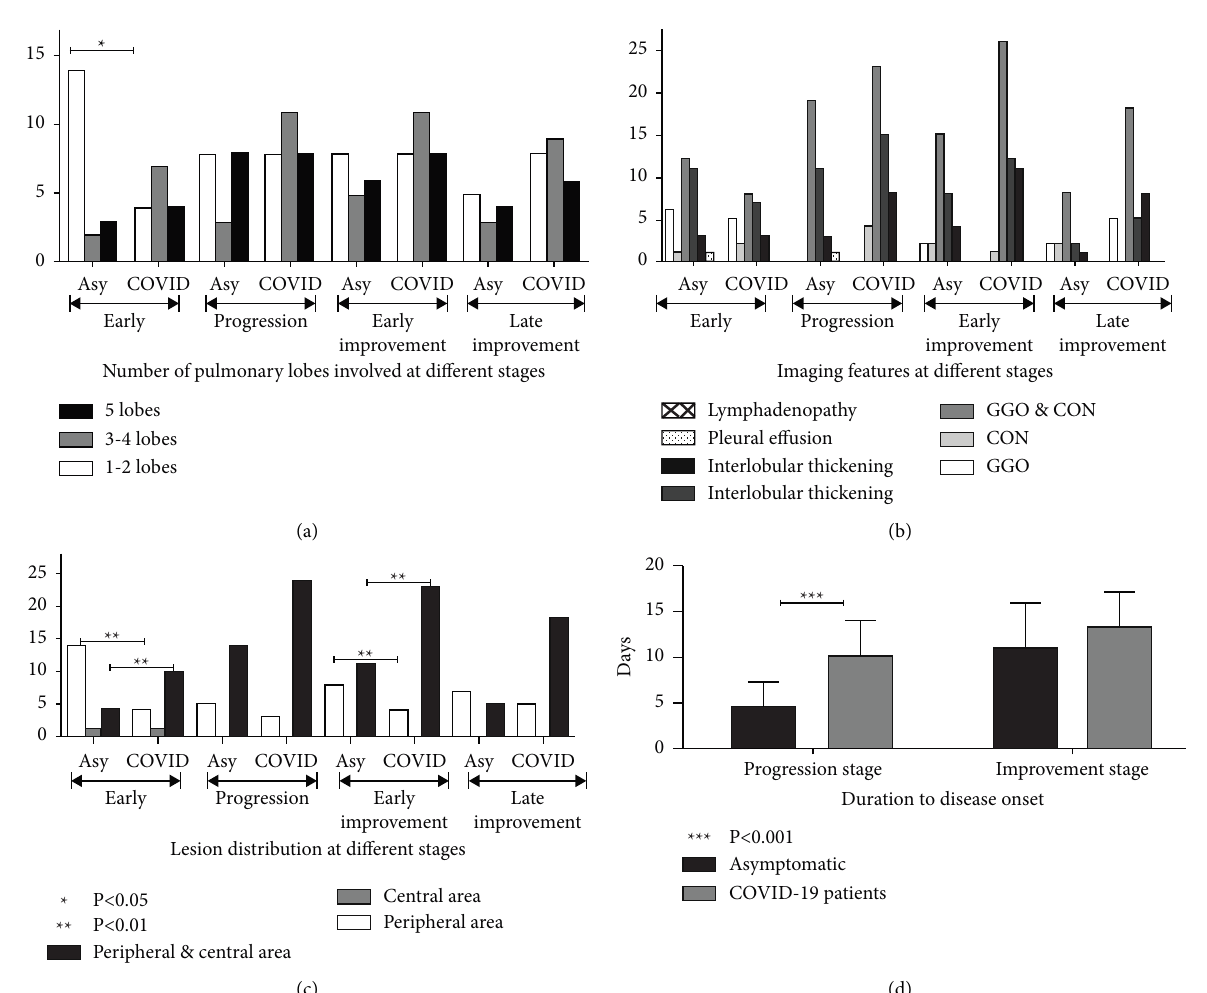
Figure 2: Te imaging features of asymptomatic carriers (Asy) and symptomatic COVID-19 patients. (a) Te pulmonary lobes that are involved at diferent stages of the two populations (asymptomatic carriers vs. COVID-19 patients). (b) Te density of lesions in the lungs, as well as interstitial changes in the lungs of the two populations (asymptomatic carriers vs. COVID-19 patients). (c) Te distribution of lesions of the two populations (asymptomatic carriers vs. COVID-19 patients). (d) Te duration from progression and improvement stages to disease onset of the two populations (asymptomatic carriers vs. COVID-19 patients). ∗ GGO, ground-glass opacity; CON, consolidation.